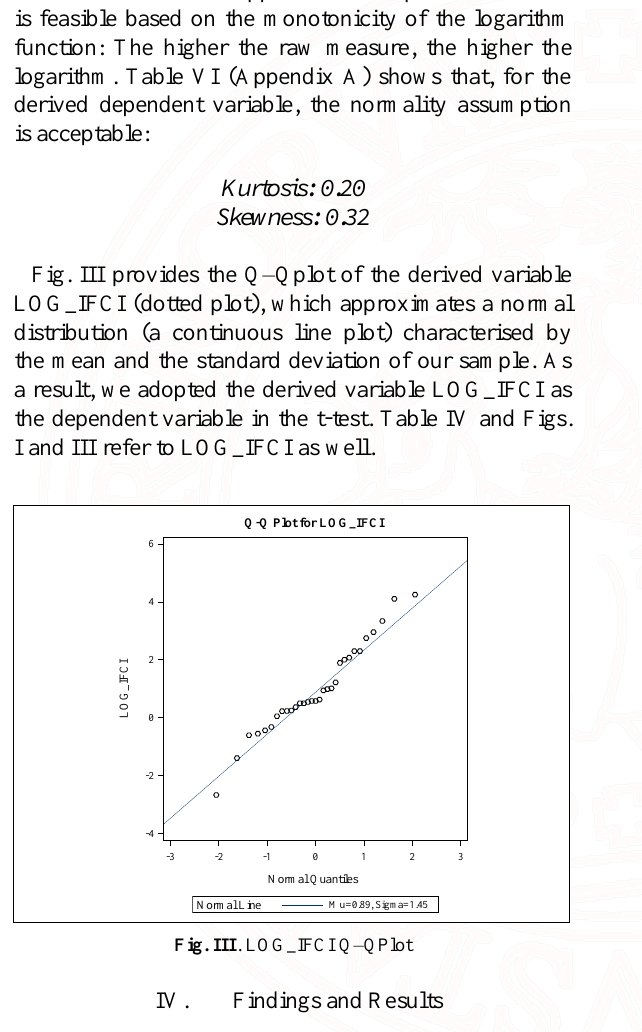
Fig. III . LOG_IFCI